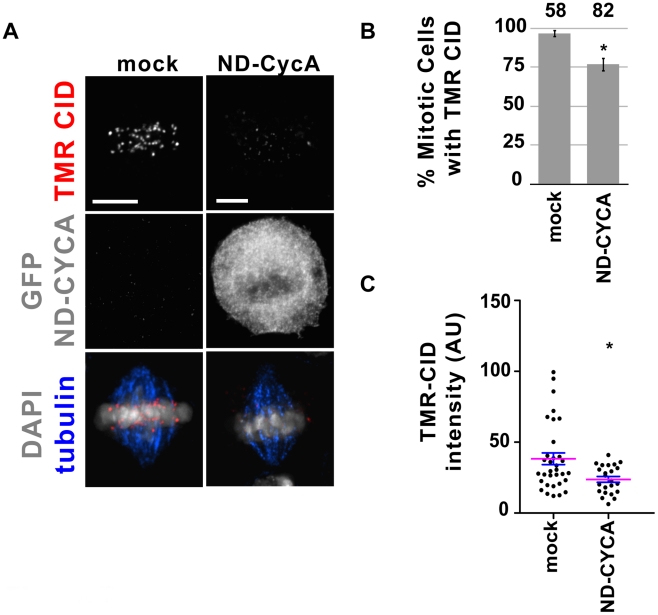
Presence of non-degradable CYCA in metaphase reduces the efficiency of CID recruitment.A) Representative images of metaphase cells transfected without plasmid (mock) and with GFP-Δ55-CYCA. After transfection, SNAP-CID S2 cells were BTP-blocked and TMR-labeled 4 h later. Cells transfected with GFP-Δ55-CYCA showed reduced SNAP-CID recruitment. TMR-CID is shown in red, GFP-Δ55-CYCA in gray, tubulin in blue and DAPI in gray. Bar = 5 µm. B) Percent of mitotic cells (y-axis) displaying centromeric TMR-CID 4 h following the BTP-block. Fewer cells recruited new CID when transfected with GFP-Δ55-CYCA (n = 82) compared to mock-transfected cells (n = 58) (* p<0.05; Fisher's exact test). Error bars represent standard error. C) Distribution of the average TMR-CID intensity in mock and transfected cells. Each dot represents individual cells. Mean (magenta) and standard error bars are shown (* p<0.05; Fisher's exact test). AU = arbitrary units.